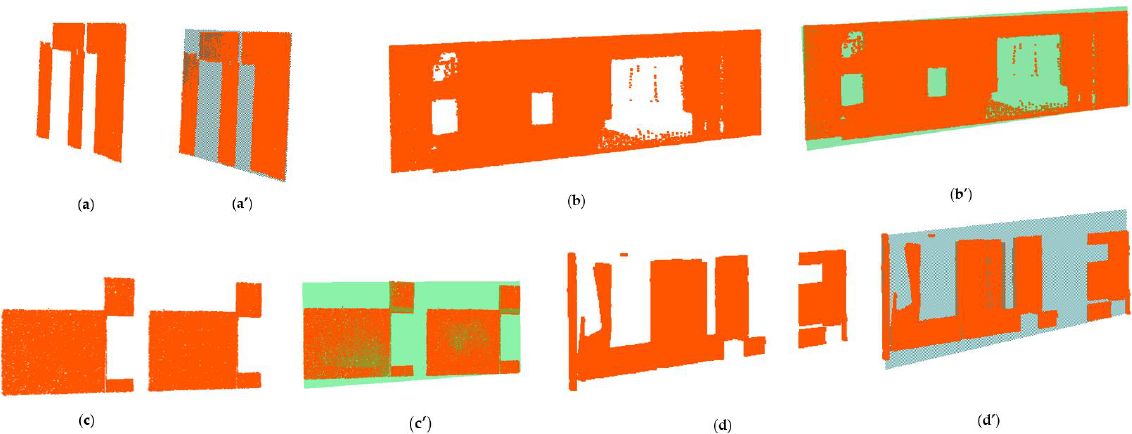
Figure 18. Results of spanning the vertical principal planes and the subsequent assignment of disconnected coplanar patches: ( a – d ) disconnected principal patches; ( a’ – d’ ) planes fitted after spanning the principal patches and assigning the corresponding coplanar patches.